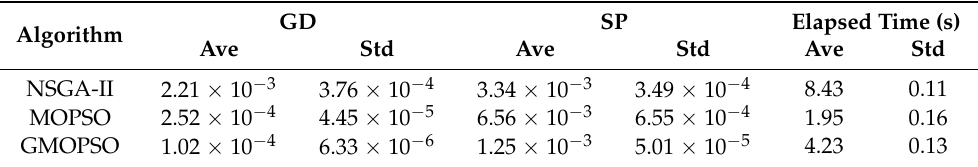
Table 3. Performance comparison for NSGA-II, MOPSO and GMOPSO in test function